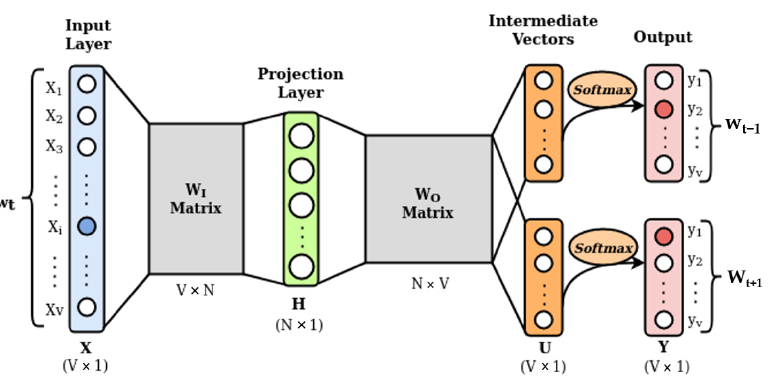
Figure 3. Skip-gram model considering the target word w t encoded in its one-hot vector X as input. This vector represents the target word as a sequence of 0s V , except for a single value 1 in the position x i . The C probability distribution vectors are obtained at the output of the model, one for each word in the context. With the model properly trained, it is expected that the highest probabilities of each vector Y , found in the positions y 2 and y 1 , will express the context words w t − 1 and w t + 1